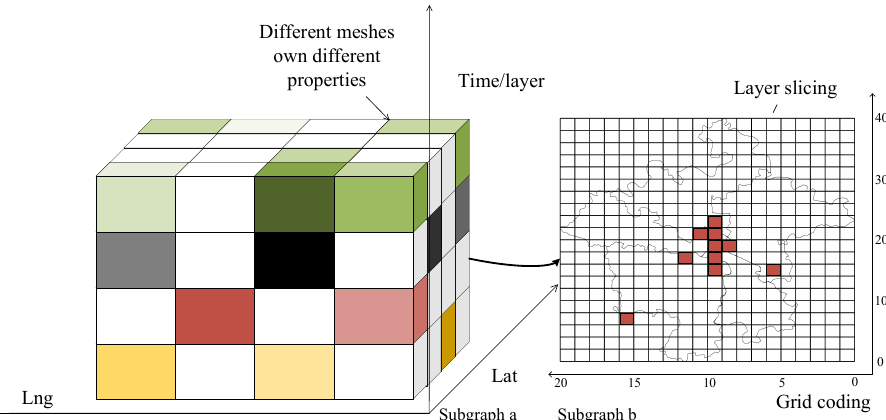
Figure 2. Space-time cube model (The left side is the a-subfigure, which shows the cube model, and the right side is the b-subfigure, which shows the layer slice).